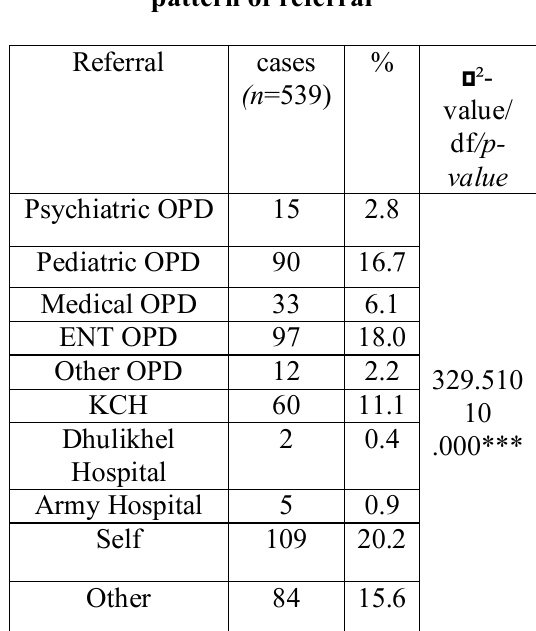
Table 2: Distribution of cases according